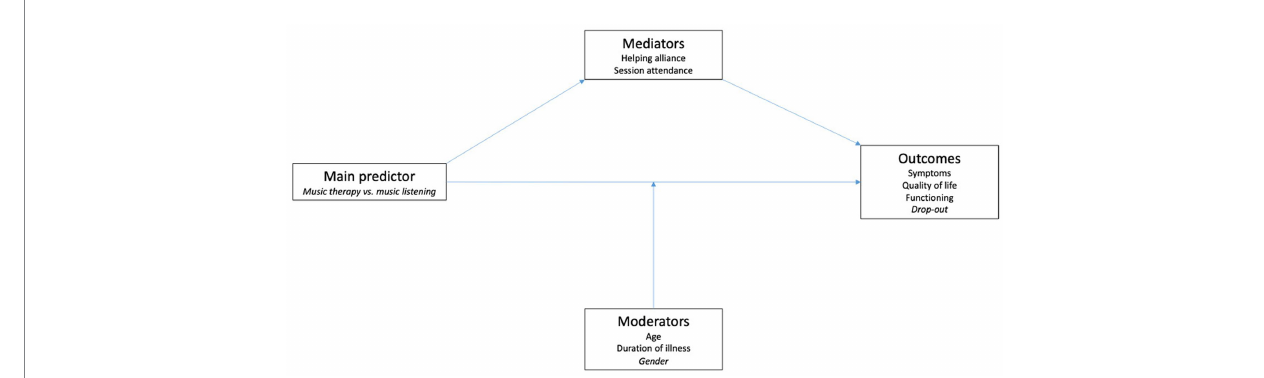
FIGURE 1 Conceptual mediational model of possible process-outcome relations in music interventions for people with schizophrenia. Continuous variables are shown in plain font, binary variables in italics. Helping alliance was measured at several time points (5, 15, 25